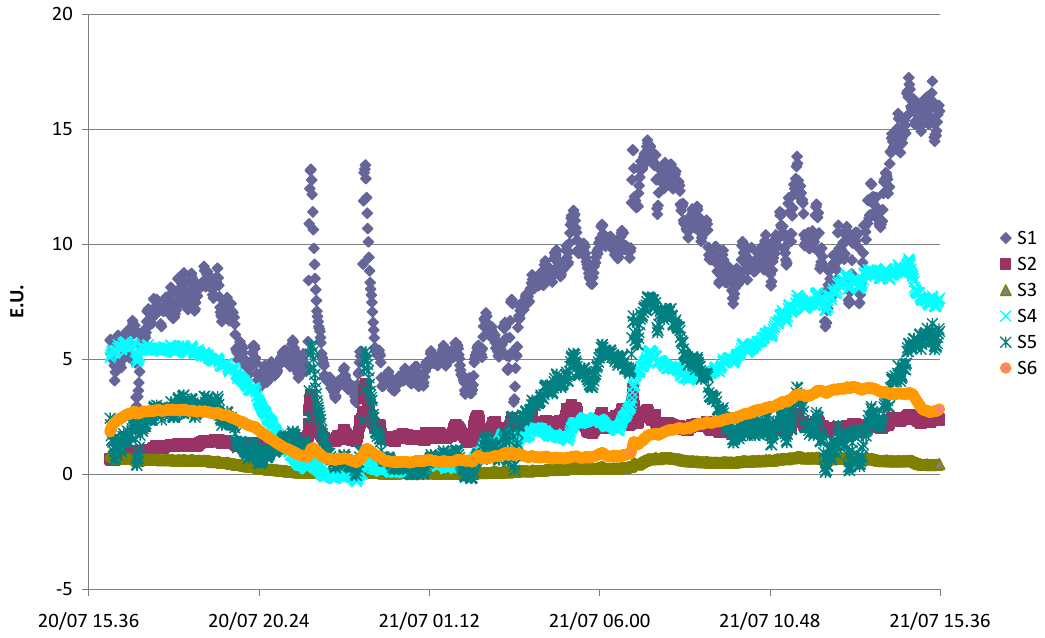
Figure 9. Plot of the EOS 507_05 monitoring data (E.U.) for the six sensors (named S1-S6 in Table